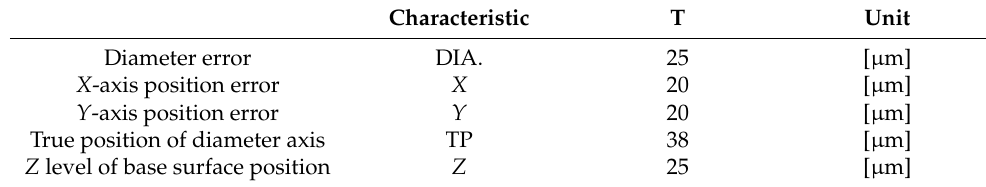
Table 5. The manufacturing tolerances of machining process requirements. Characteristic T Unit Diameter error